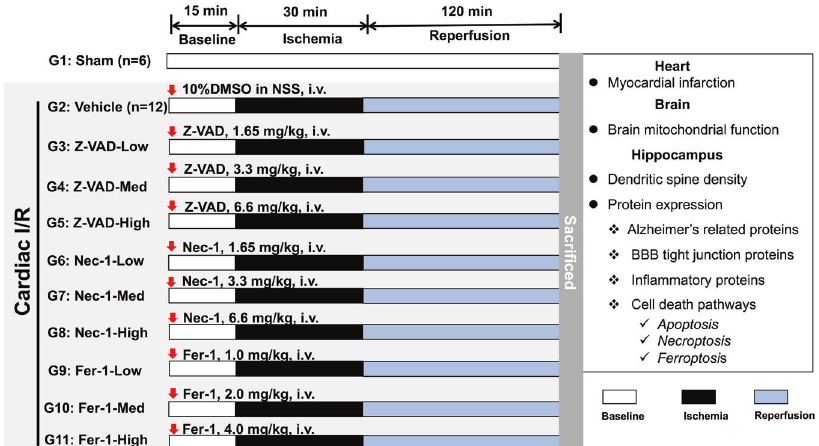
Fig. 7 The experimental protocol of this study. One-hundred and twenty-six male Wistar rats were subjected to either sham operation (G1: sham, n = 6) or cardiac I/R operation (G2-G11, n = 12/group). Rats in cardiac I/R group were pretreated with either 10% DMSO in normal saline solution (G2: vehicle, n = 12) or cell death inhibitors, including an apoptosis inhibitor (Z-VAD), a necroptosis inhibitor (Nec-1), and a ferroptosis inhibitor (Fer-1). All inhibitors were subdivided into three different doses, including low, medium (Med), and high dose ( n = 12/group). I/R ischemia/reperfusion injury, i.v. intravenous, DMSO dimethyl